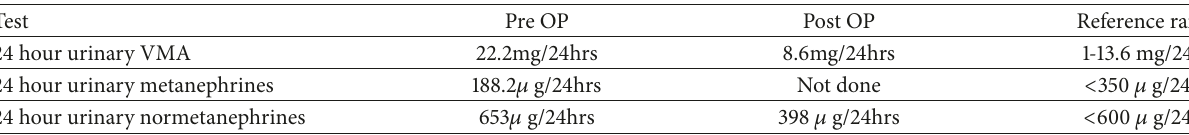
Table 1: Postoperative investigations.